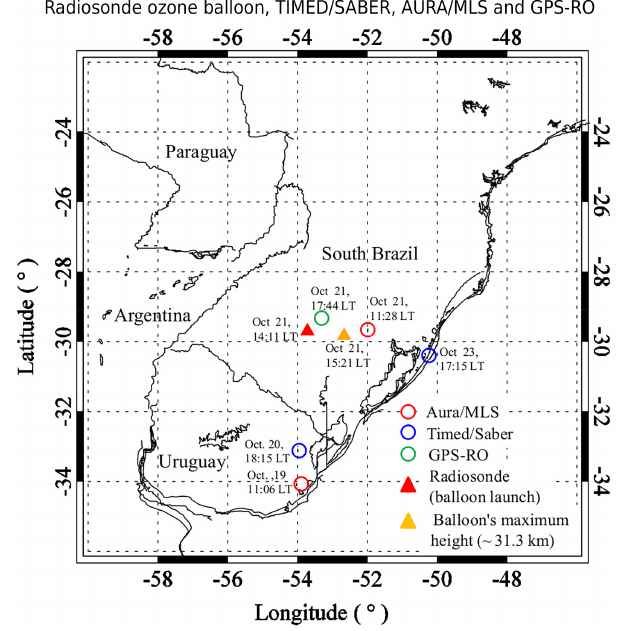
Figure 2. TIMED/SABER (blue circle) and AURA/MLS (red cir- cle) sounding locations from 19 to 23 October 2016. On 21 October the balloon sounding (red triangle, launch; orange triangle, apex) and the GPS-RO sounding (green